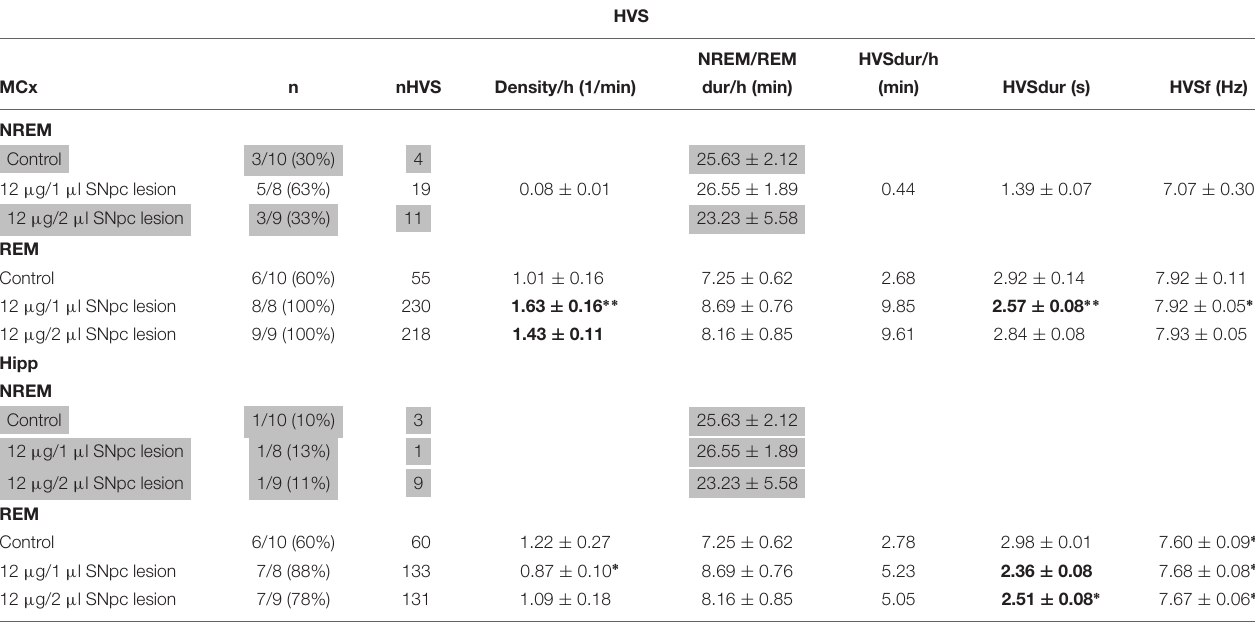
TABLE 3 | High voltage sleep spindles (HVS) dynamic during NREM and REM sleep.